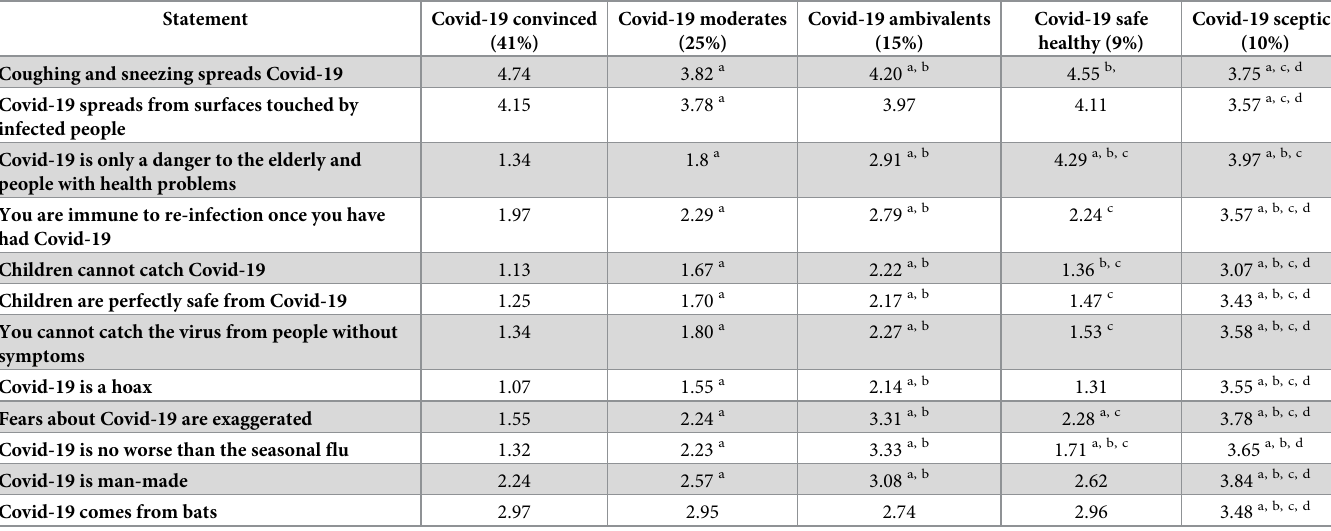
Table 5. Belief segments for